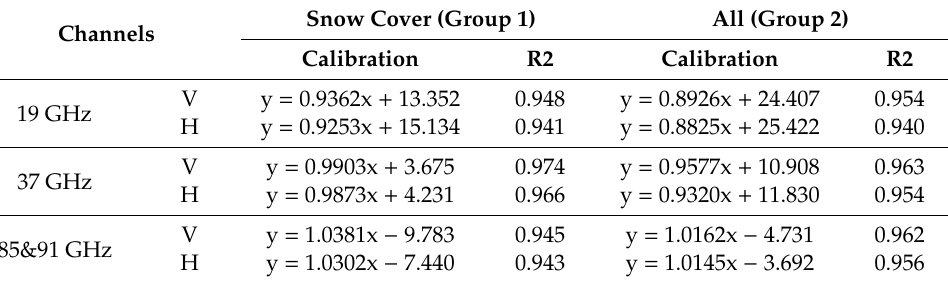
Table 7. Summary of intercalibration between SSM/I and SSMIS.